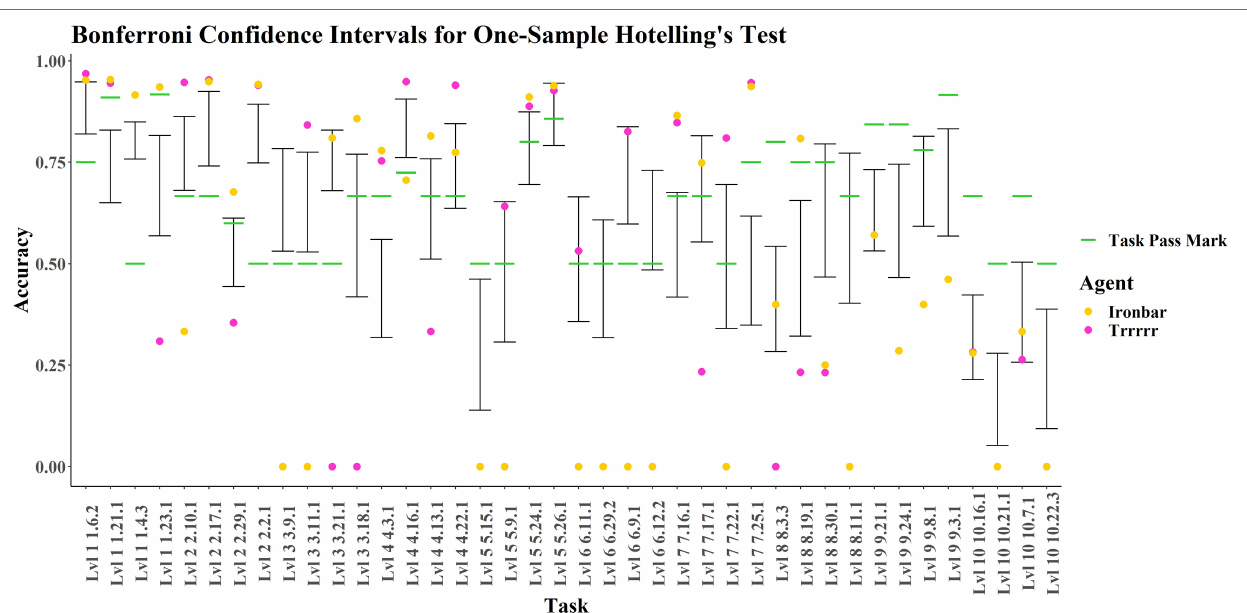
FIGURE 7 | Bonferroni confidence intervals for children’s data at alpha = 0.05 with ‘ironbar’ and ‘Trrrrr’ results and pass marks